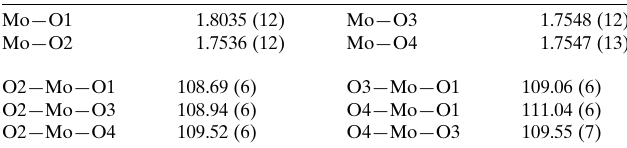
Table 2 Hydrogen-bond geometry (A˚ , (cid:5) ).